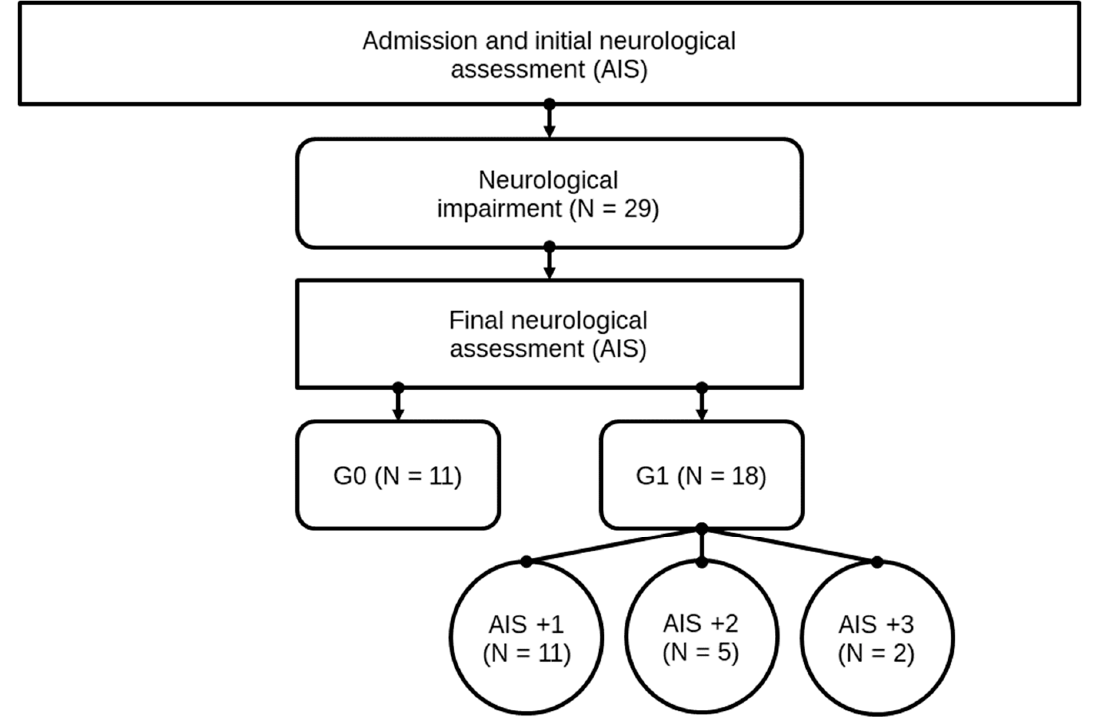
Figure 3. Patient collective identification scheme. Abb.: G0 / G1 = patients with (G1) or without neurological remission (G0) after 3 months, AIS +1 / AIS +2 / AIS +3 = patients with a